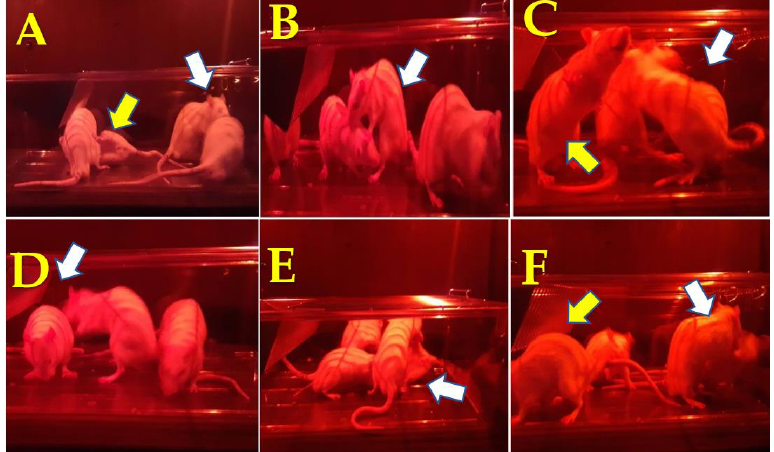
Figure 3. Distinctly visible signs of pre-copulatory actions of rats treated with J. macrantha and sildenafil. ( A ): circling around (yellow arrow), and body-sniffing (white arrow), ( B ): mounting (white arrow), ( C ): ear-wiggling (white arrow) and grooming (yellow arrow), ( D ): anogenital exploration (white arrow), ( E ): circling around (white arrow), ( F ): lordosis (yellow arrow), and mounting (white arrow).